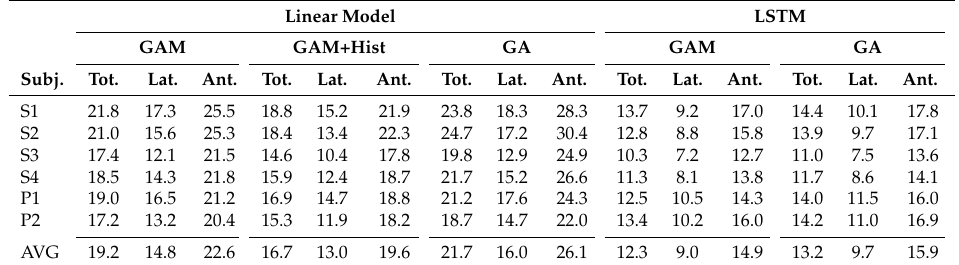
Table 3. Intra-subject test RMS error [mm] for various input data. The total RMS error (Tot.) is split between the lateral (Lat.) and anterior (Ant.) components. Columns ‘GAM’ label models with the full input of gyroscope, accelerometer, and magnetometer data from all IMUs. Column ‘GAM+hist’ additionally includes the most recent 0.1s IMU data in the input. Note, that the inclusion of ‘history’ in the input to linear model results in significant improvement in the RMS error. Linear Model LSTM GAM GAM+Hist GA GAM GA Subj. Tot. Lat. Ant. Tot. Lat. Ant. Tot. Lat. Ant. Tot. Lat. Ant. Tot. Lat. Ant.